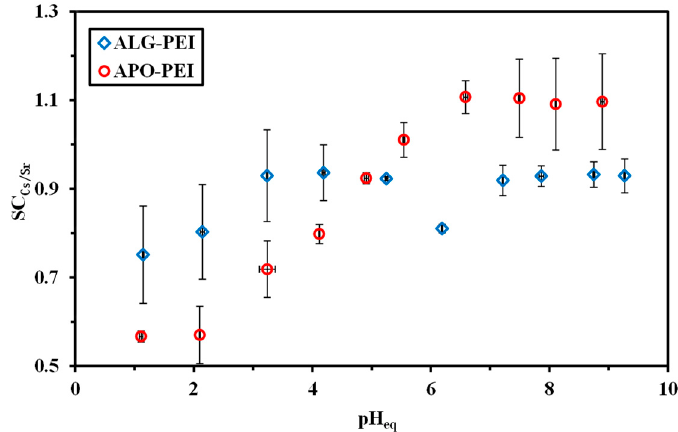
Figure A11. Effect of the pH on the selectivity coefficient (SC Cs/Sr ) using ALG-PEI and APO-PEI sorbents (binary solutions: 0.754 mmol Cs L − 1 and 1.227 mmol Sr L − 1 ; SD: 0.67 g L − 1 ; v: 210 rpm; time: 48 h; T: 21 ± 1 °C).